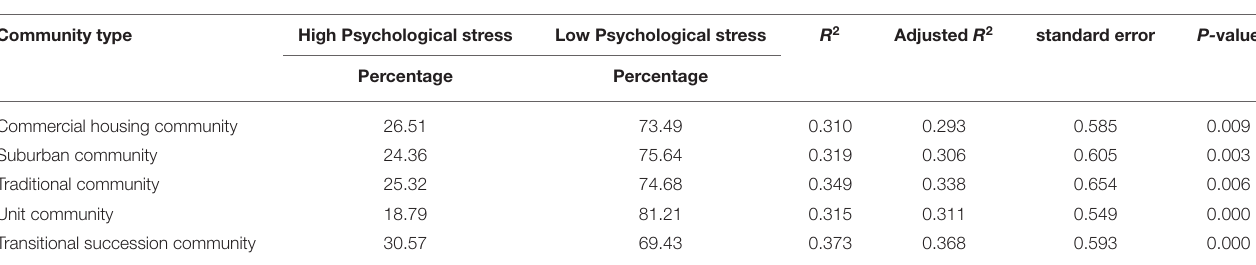
TABLE 6 | Moderating effect of community